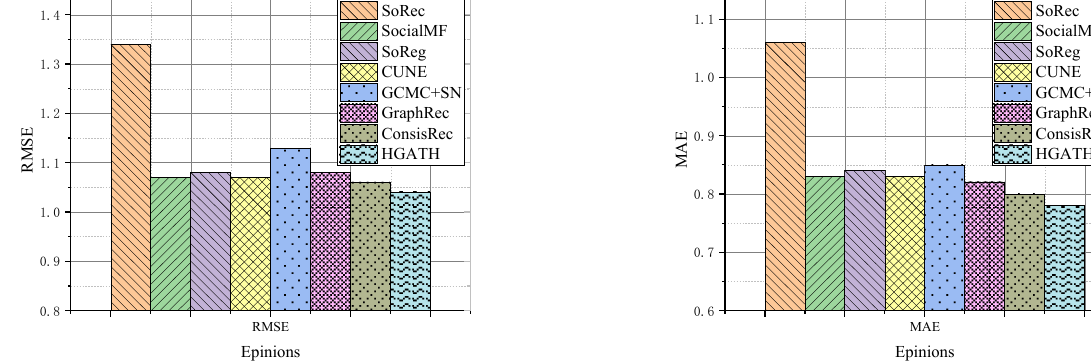
Figure 3. The experimental results of all compared algorithms on the two datasets. ( a ) RMSE based on Ciao dataset HGATH compared with other state-of-the-art algorithms ( b ) MAE based on Ciao dataset HGATH compared with other state-of-the-art algorithms ( c ) RMSE based on a comparison of the Epinions dataset HGATH compared with other state-of-the-art algorithms ( d ) MAE based on a comparison of the Epinions dataset HGATH compared with other state-of-the-art algorithms.